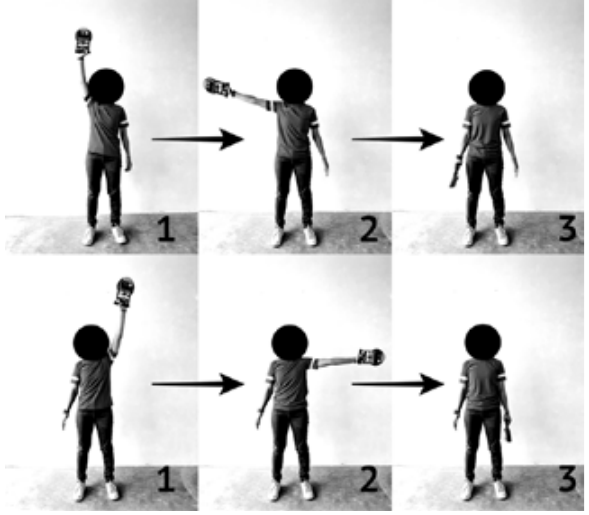
Figure 2. Steps for measuring handgrip strength Statistical Analysis